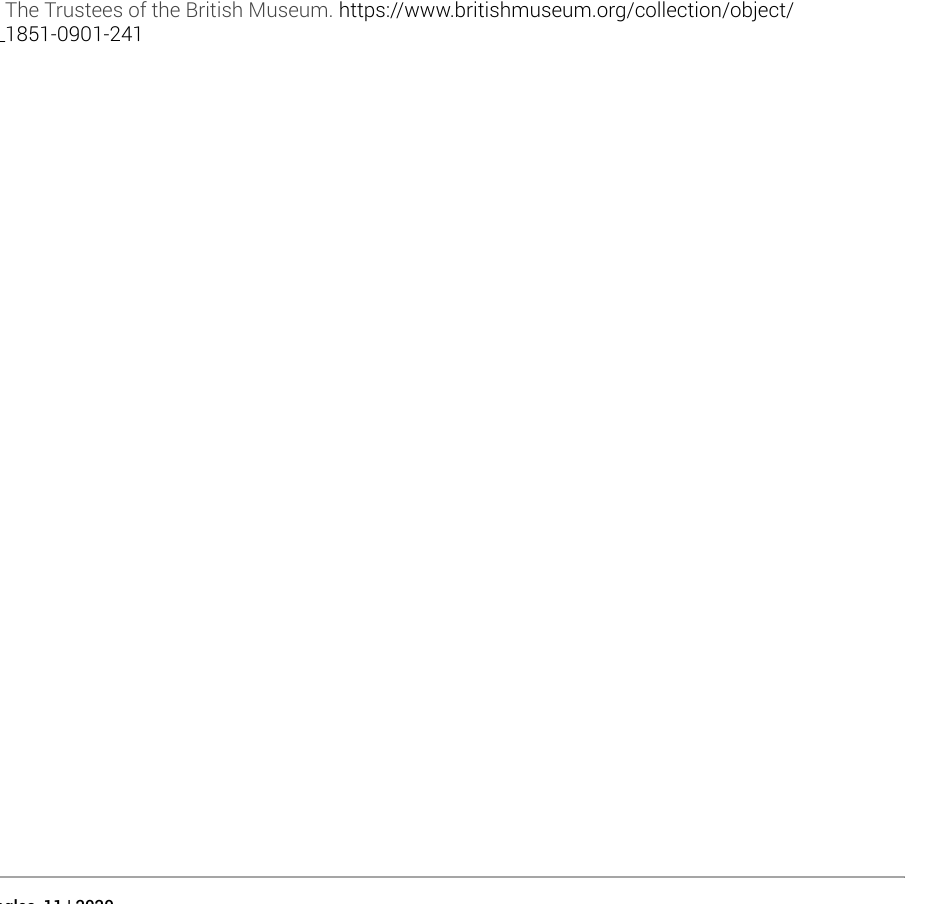
The gamblers sitting around the table are the Prince of Wales (on the right, saying: “Who sets a thousand on this?”), Fox, the Whig statesman leading His Majesty’s Opposition (in the middle, saying: “Give me the cog’d dies and I’ll nick him”) and, perhaps, Sheridan, a friend and supporter of Fox’s (on the left, answering: “I say done — at it for a thousand”). This satire on the bad influence of Fox (trying to cheat) on the Prince of Wales is one of the many circulating at the